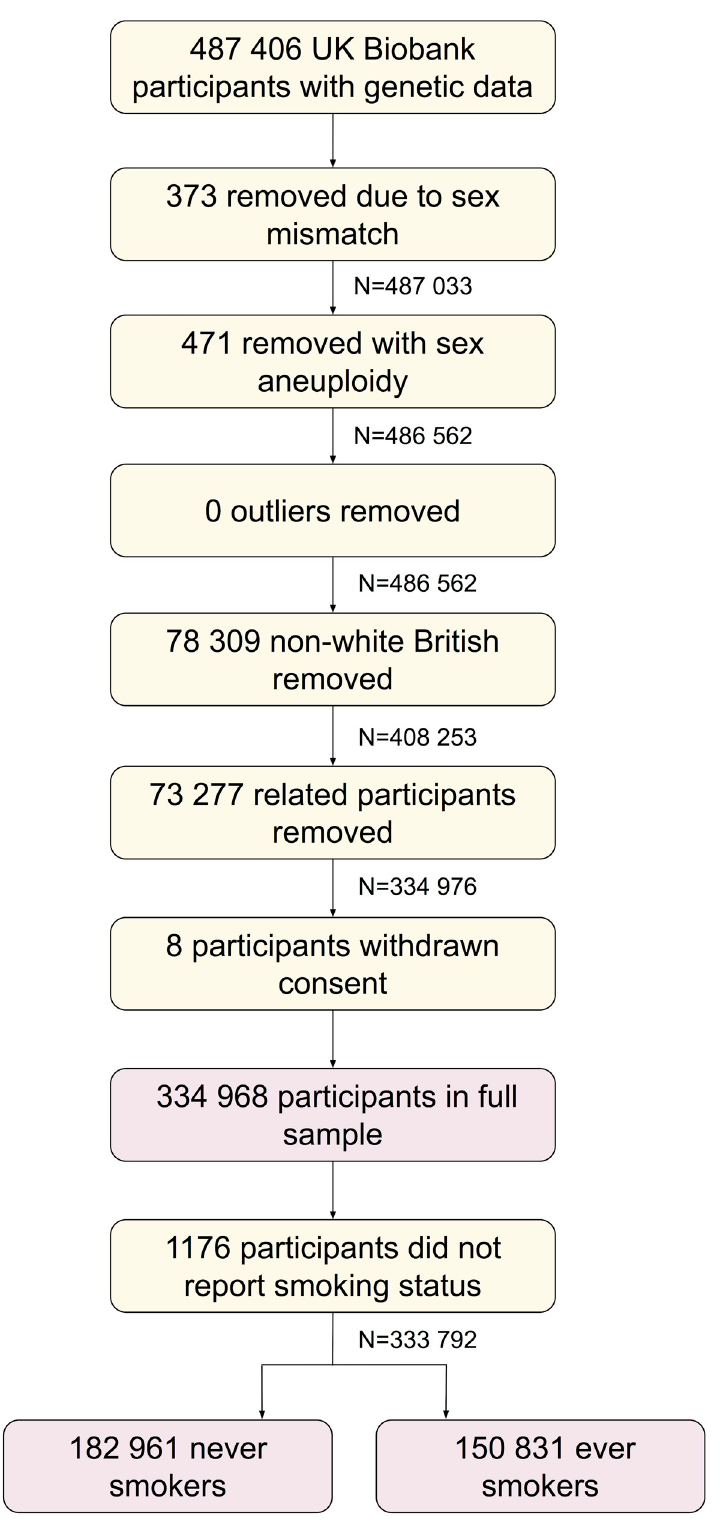
Fig 6. Participant flow